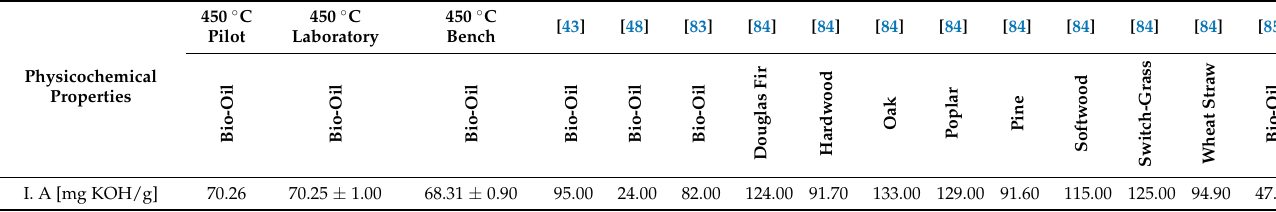
Table 4. Acid value of bio-oil obtained by pyrolysis of dried Aça í seeds at 450 ◦ C and 1.0 atmosphere, compared to similar data reported in the literature [43,48,83–85].